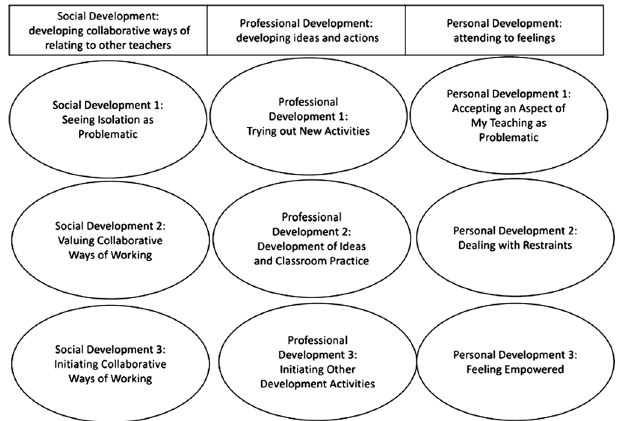
FIG. 1. Bell and Gilbert ’ s framework ’ s diagram representation in the context of New Zealand ’ s science teachers ’ development during a professional development program [19] As indicated before, we will be using the term domain to refer to each of these development